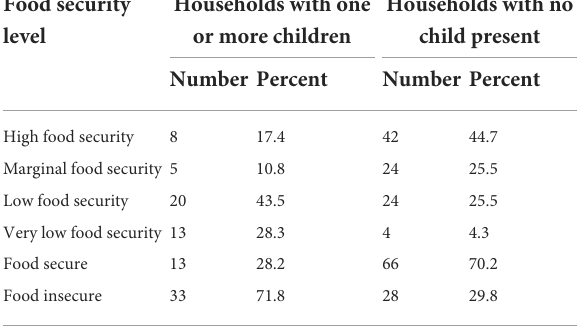
FIGURE3 The status of household food security based on having and not-having child.